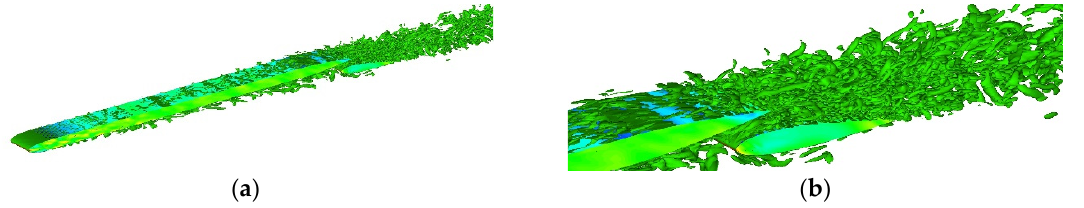
Figure 9. z-direction vorticity contours.